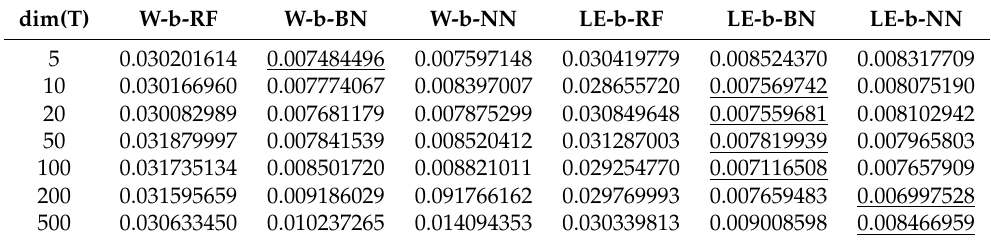
Table 10. Computational time of issuing all prediction in test set with different dimensions.